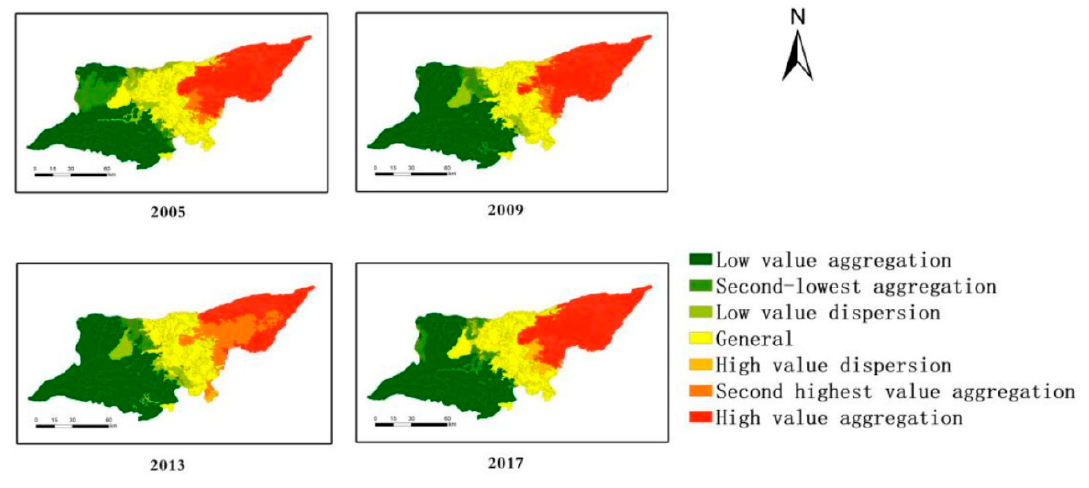
Figure 9. Autocorrelation characteristics of groundwater depth.